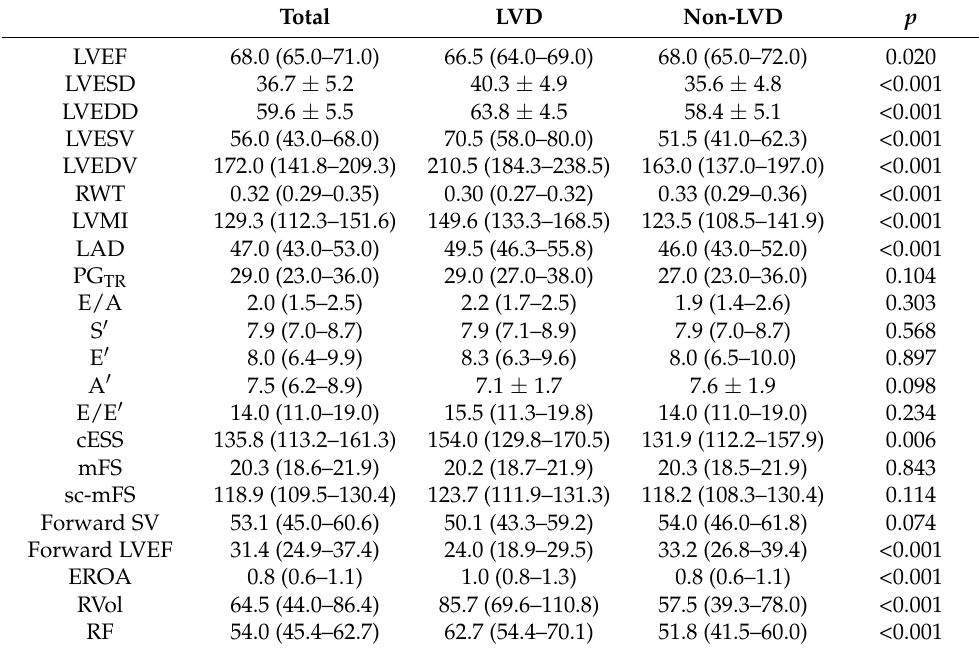
Table 2. Preoperative echocardiographic findings.